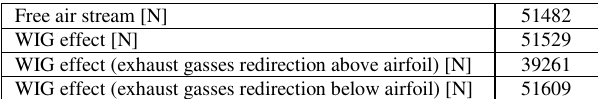
Table 2. Lift force values for NACA M8 profile